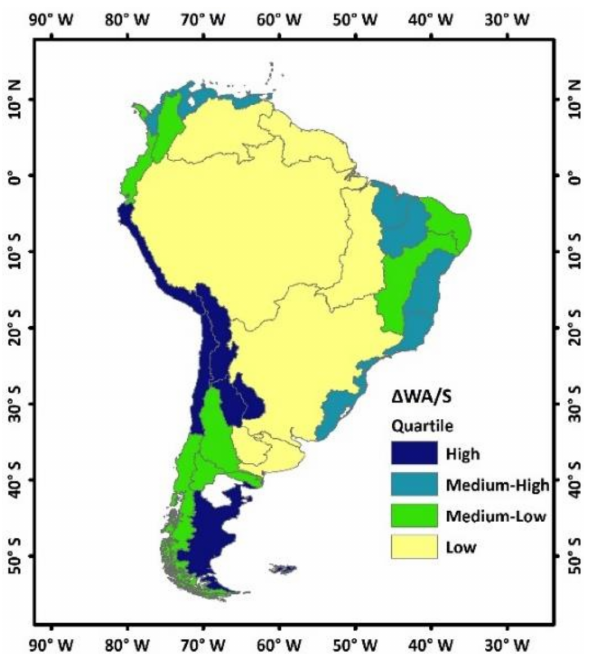
Figure 7. Relationship between the increment of water availability and storage ( ∆ WA/S) mapped as quartiles. See Table 3 for specific